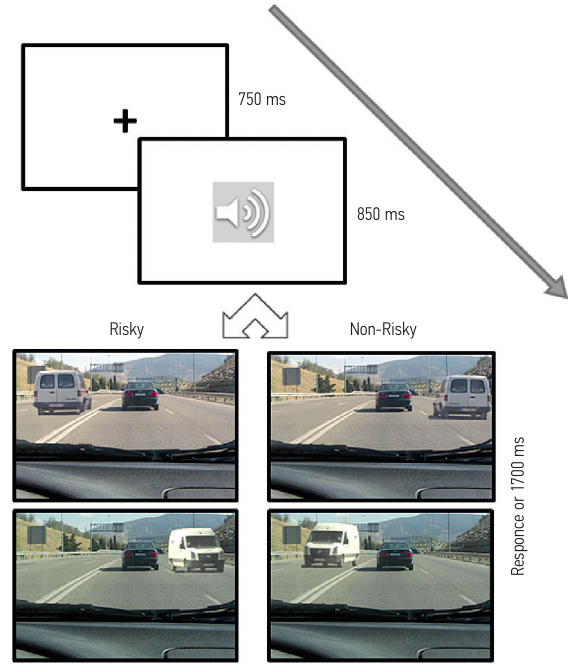
Fig. 1. Experimental procedure and